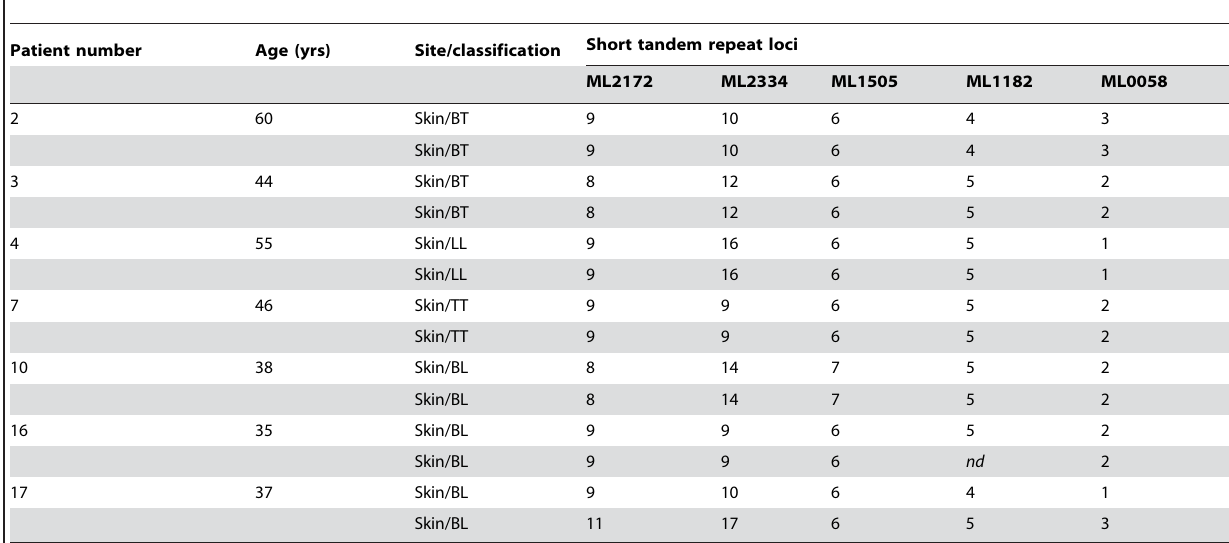
Table 3. Comparison of copy numbers of short tandem repeat loci in multiple skin biopsies taken at the same time, from different lesions, from individual patients in